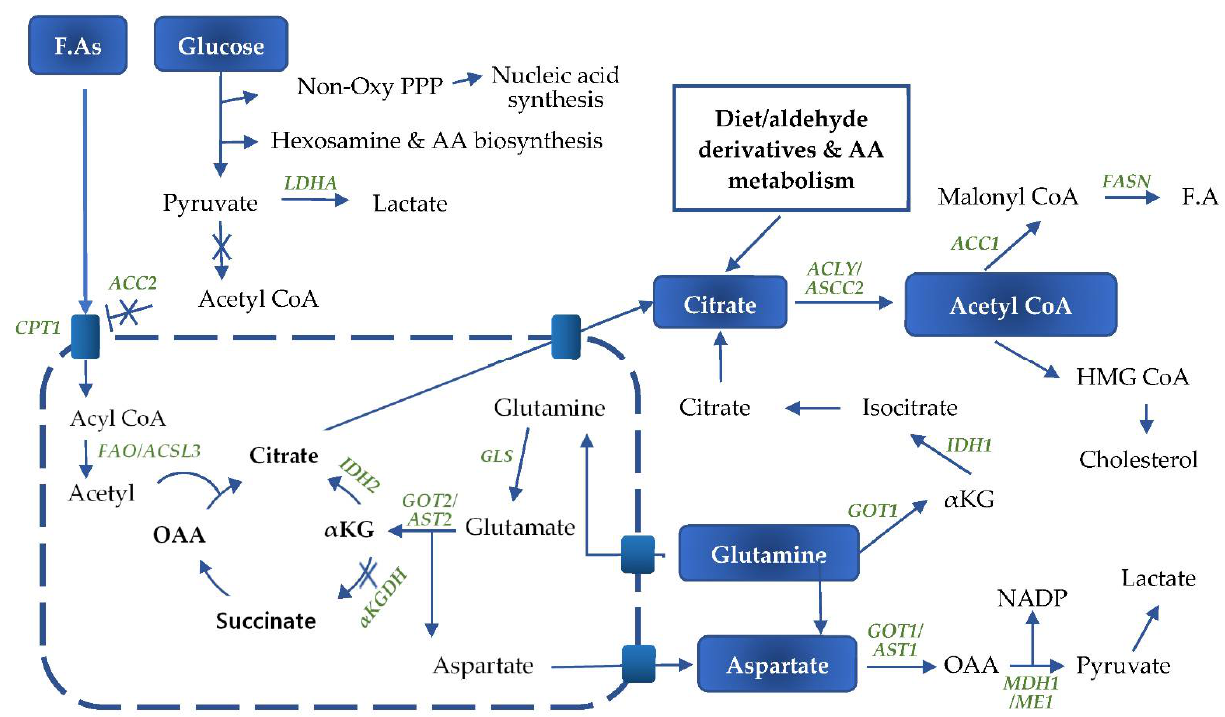
Figure 2. Mutant KRAS induced rewiring of metabolism in pancreatic cancer cells to both the canonical and non-canonical glutaminolysis pathways. Oxy PPP—oxidative pentose phosphate pathway; AA—amino acids. Forward arrow: pathway progression; Forward arrow with a cross: progression is inhibited; Blunt end arrow with a cross: Absence Malonyl-CoA generation from Acetyl-coA prevents normal inhibition of CPT1.